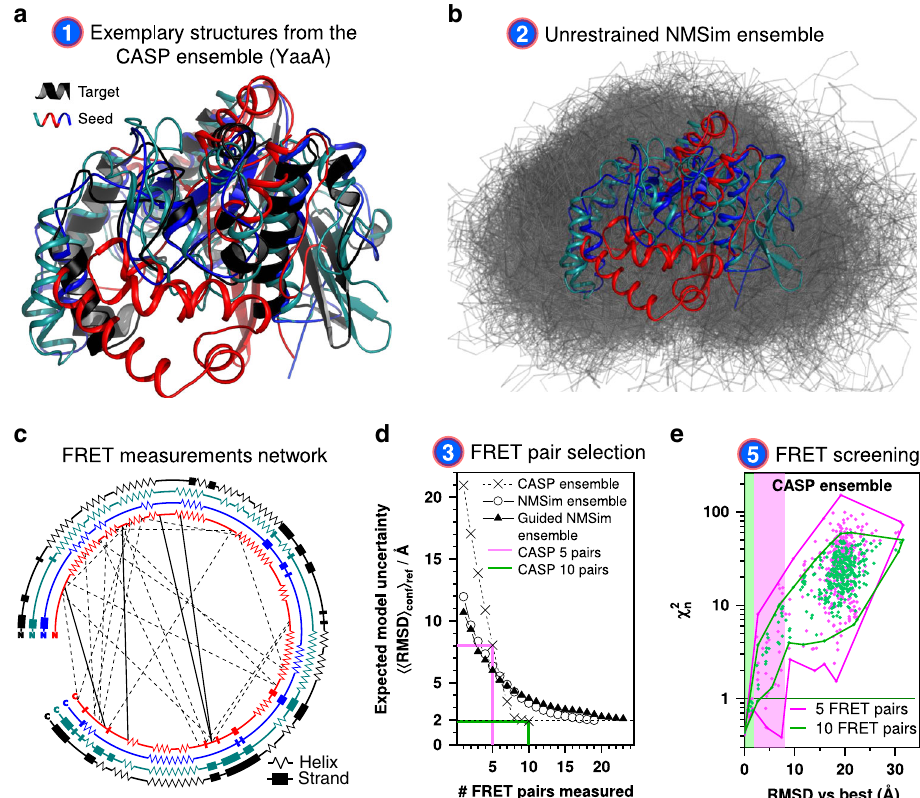
Fig. 2 Automated FRET-assisted structure prediction demonstrated on the E. coli protein YaaA. a Collection of structures used as prior knowledge. The CASP predictions serving as seed structures (red, cyan, blue), and the target crystal structure of YaaA (black, PDB ID: 5CAJ) are shown as cartoon representations. The conformers differ in their secondary structure and folds (see also c ). For clarity, only three out of the ten used seed structures are shown. b Generation of the initial structural ensemble (gray) by NMSim without FRET information, using the CASP predictions (red, cyan, blue) as seeds. c Network of FRET pairs used for FRET-guided NMSim (dashed lines) and screening (dashed and solid lines). Secondary structure elements of the three shown seed structures (red, cyan, blue) and the target (black) are represented by zigzags ( α -, 3 10 -, or π -helices), rectangles ( β -sheets), and lines (loops). d Expected uncertainty of the resulting structure, depending on the number of FRET measurements used for modeling. For sparse conformational ensembles as the CASP ensemble (crosses), the decay is steeper compared to the dense ensembles generated by NMSim (circles). e Impact of the number of FRET restraints on the uncertainty of the selected ensemble. The χ 2 values and RMSD vs. the structure in best agreement with the simulated or experimental n information is shown for the structural ensemble of the CASP targets. The set of the structures with a χ 2 lower than 1.0 de fi nes the uncertainty of the FRET- n selected structure. The green and magenta shaded areas correspond to 10 and 5 FRET measurements, respectively. Source data are provided as a Source Data fi le. Table 1 Summary for the proteins used in this benchmark study a .